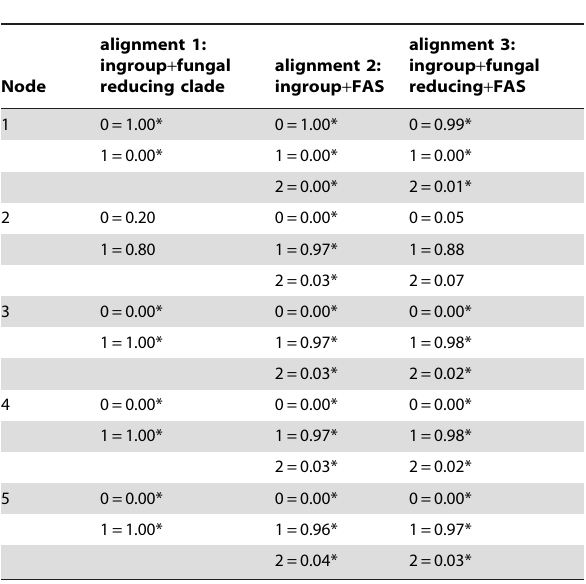
Table 2. Ancestral character state reconstructions performed in a combined Bayesian/ML framework.